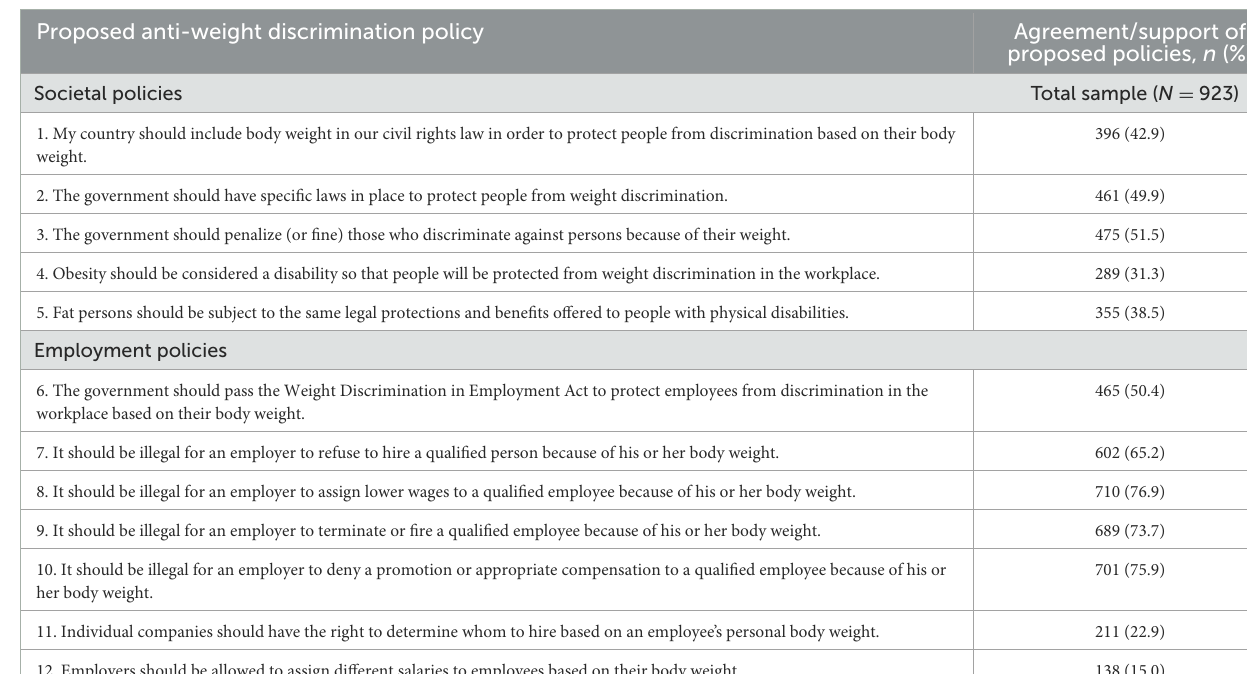
TABLE 2 Support for anti-weight discrimination